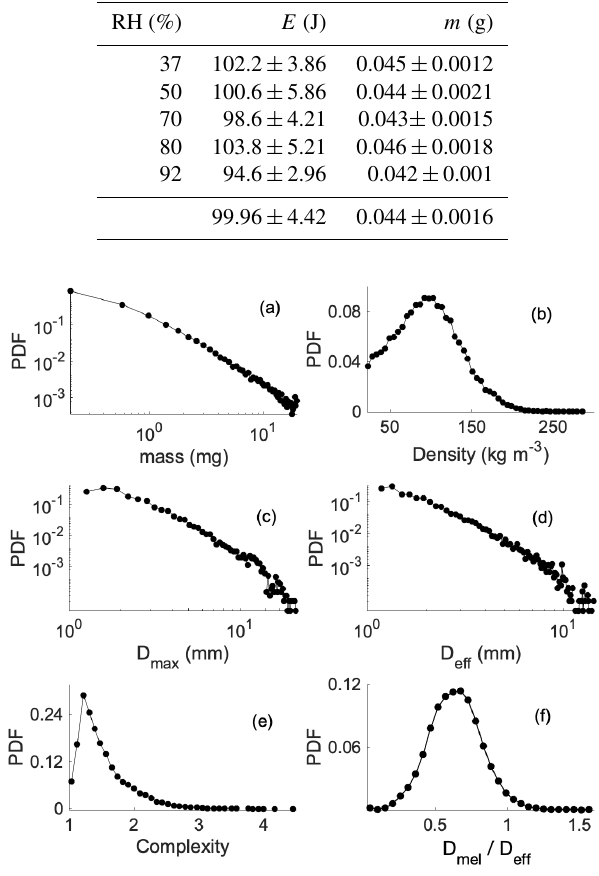
Figure 8. Distributions of snowflake characteristics measured us- ing the DEID at the Alta-Collins Snow Study Plot from a sample of 45718 snowflakes: (a) mass, (b) density, (c) maximum effective diameter D max , (d) effective circular diameter D eff , (e) complex- ity and (f) ratio of melted spherical diameter to effective circular